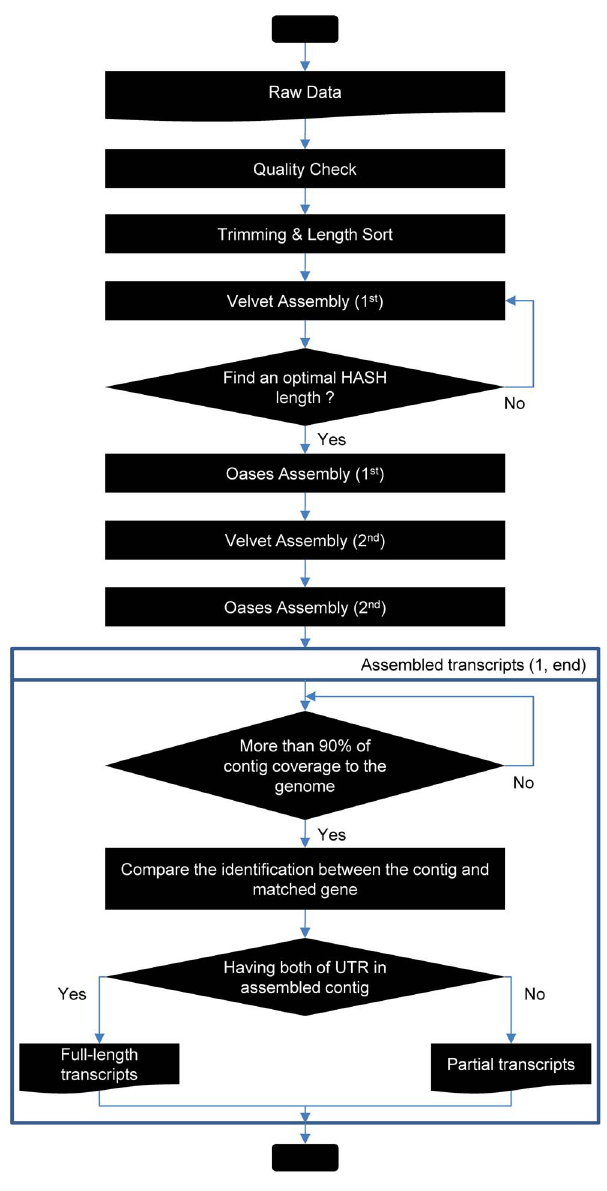
Figure 1. Workflow of the transcriptome assembly and the analysis of high-throughput sequencing data. The analysis of the transcriptome assembly and the full-length transcripts were processed as a workflow. The quality analysis of the sequence data, the data trimming, and the read length sorting were performed by the Solexa QA, Dynamic Trim, and Length sort programs, respectively. The optimal hash length for the assembly was selected by applying several hash lengths according to an in-house pipeline. The assembled transcripts with more than 90% coverage of the Arabidopsis genome were analyzed to identify full-length transcripts. The transcripts with both a 5 9 UTR and a 3 9 UTR were defined as full-length transcripts (fl-transcripts).